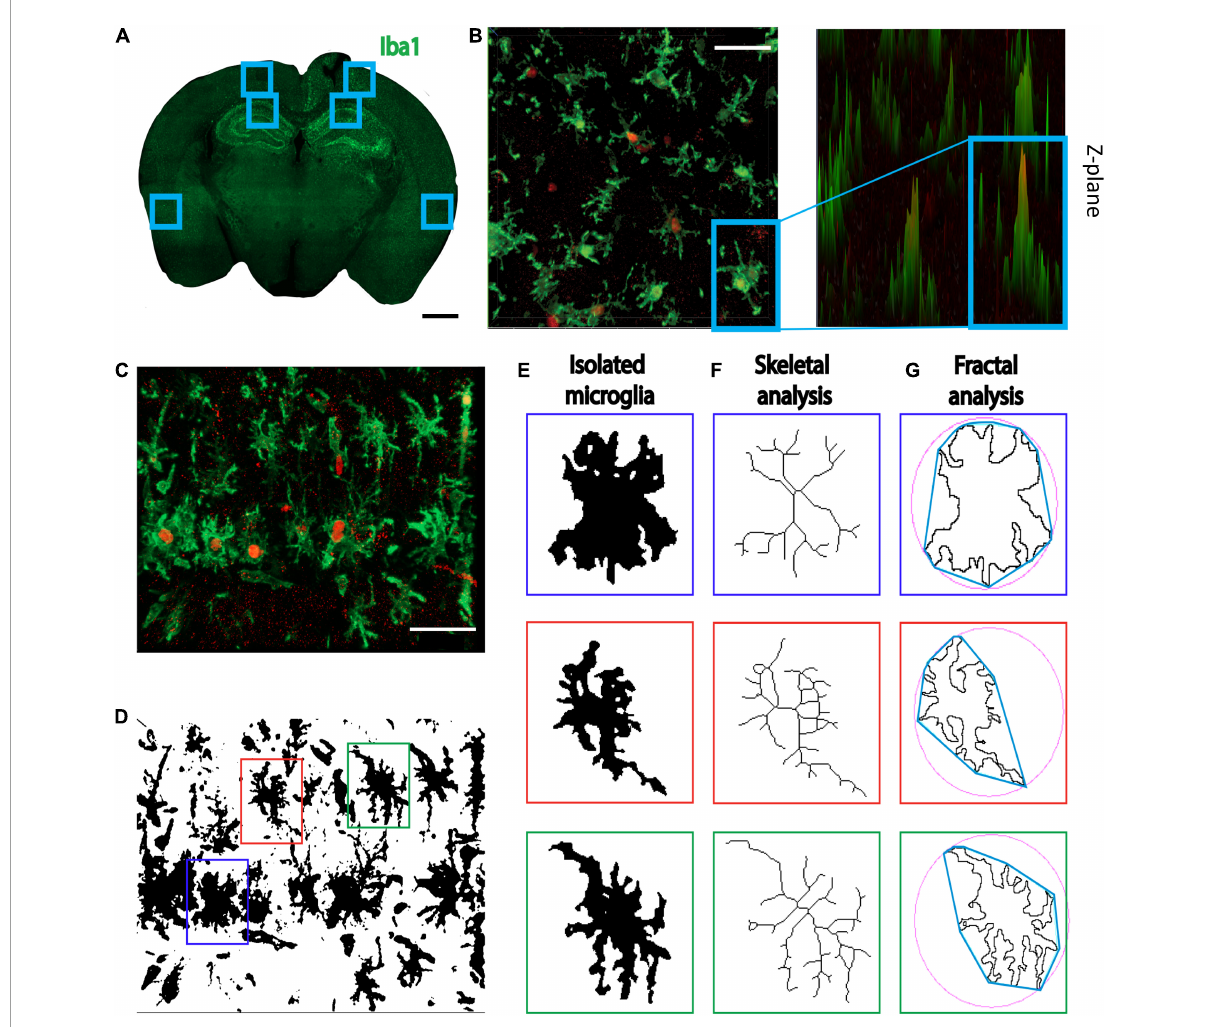
FIGURE1 Methods for individual microglia ImageJ analyses. (A) Three regions of interest were selected, the cortex adjacent to the injection site, the CA1, and the perirhinal cortex. Scale bar = 1000 µ m. (B) Iba1 + /KI67 + co-labeled cells. Images were also displayed at 2.5 renderings to ensure all co-labeled cells were counted. Scale bar = 50 µ m. (C) Representative image of 40 × Z-stacked photomicrograph of Iba1 and KI67 staining used for single cell morphology analyses. Scale bar = 50 µ m. (D) Photomicrographs were converted to binary and (E) 3 randomly selected microglia were isolated. (F) For skeletal analyses, cells were converted to skeletons and analyzed. (G) For fractal analyses, the isolated microglia were converted to outlines and analyzed. Red = KI67 staining; Green = Iba1